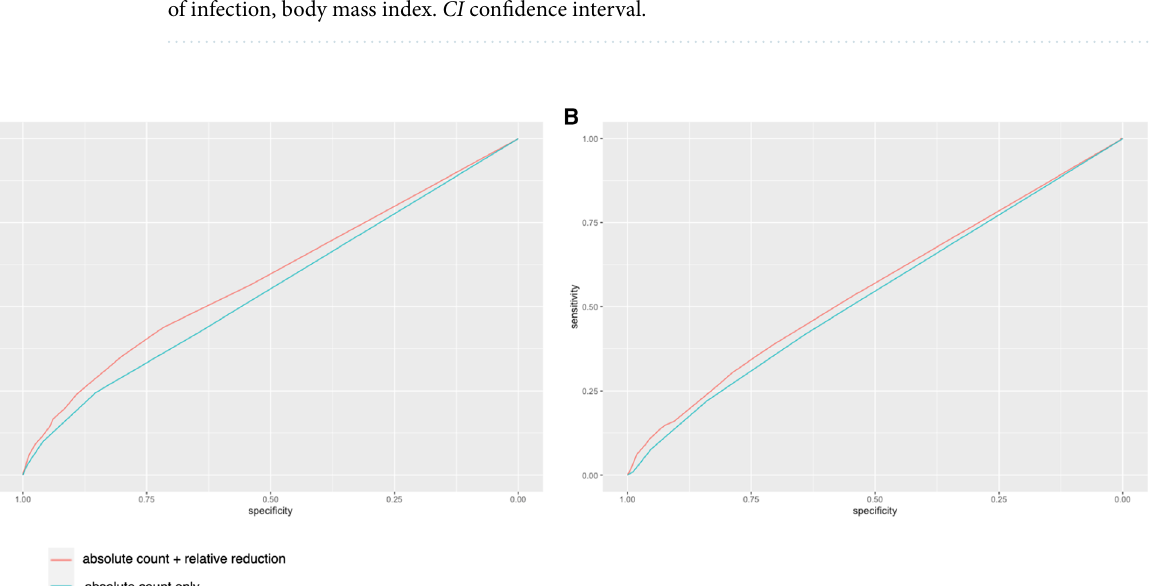
Table 3. Results of multivariate logistic regression analysis for predicting coagulopathy-related complications. Variables in the model included patient age, sex, race, Charlson comorbidity index, relative platelet reduction, absolute platelet count on day2, Acute Physiology and Chronic Health Evaluation (APACHE) IV score, focus of infection, body mass index. CI confidence interval.